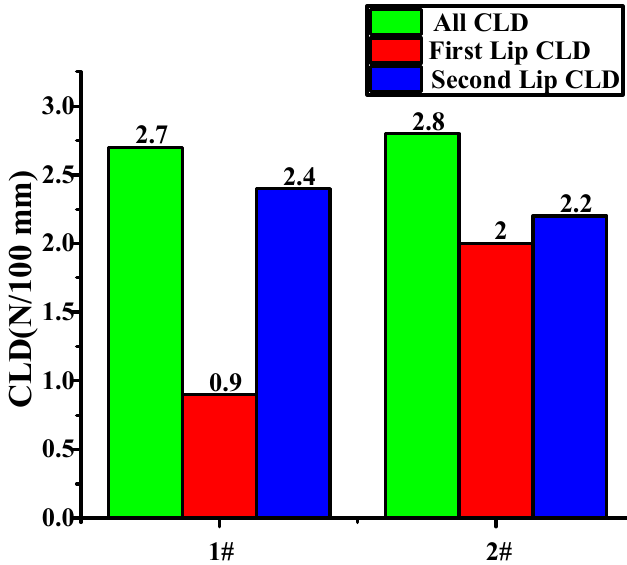
Figure 20. CLD diagram of inner belt.